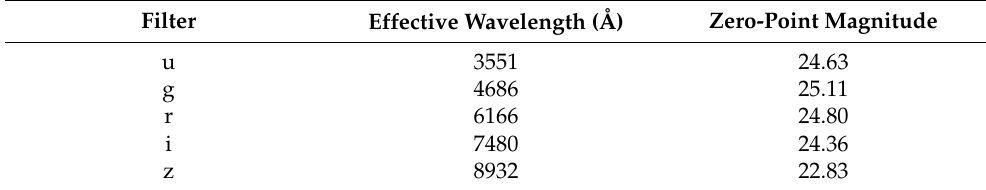
Table 5. SDSS filter effective wavelengths and zero-point magnitudes obtained from open access Sloan Digital Sky Survey repository